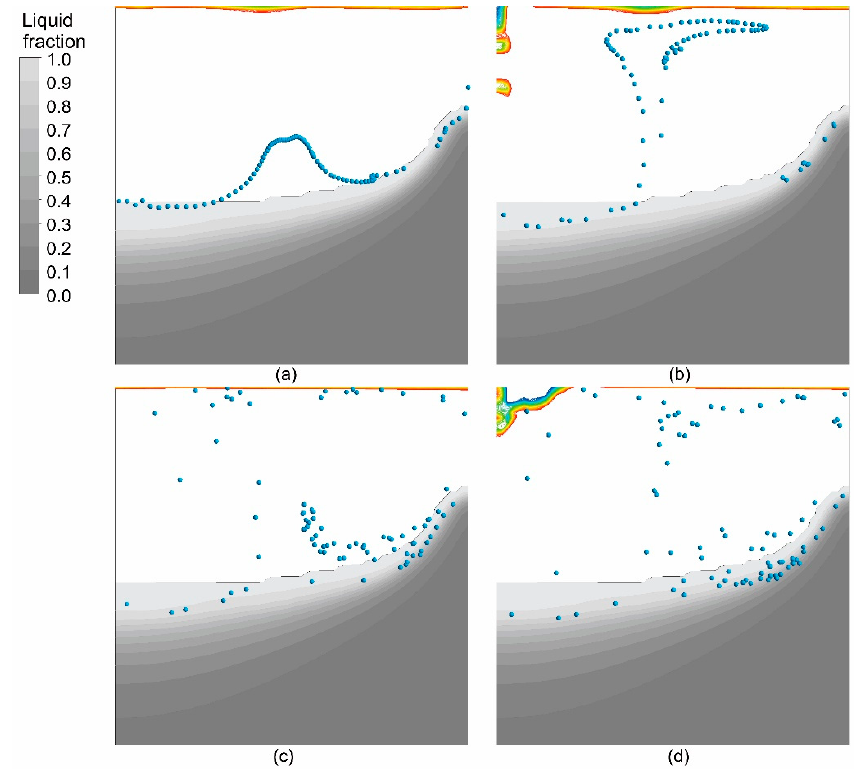
Figure 13. Predicted motion of newly generated inclusions in liquid metal pool: ( a ) t = t 0 + 1 (s); ( b ) t = t 0 + 3 (s); ( c ) t = t 0 + 10 (s); and, ( d ) t = t 0 + 30 (s).